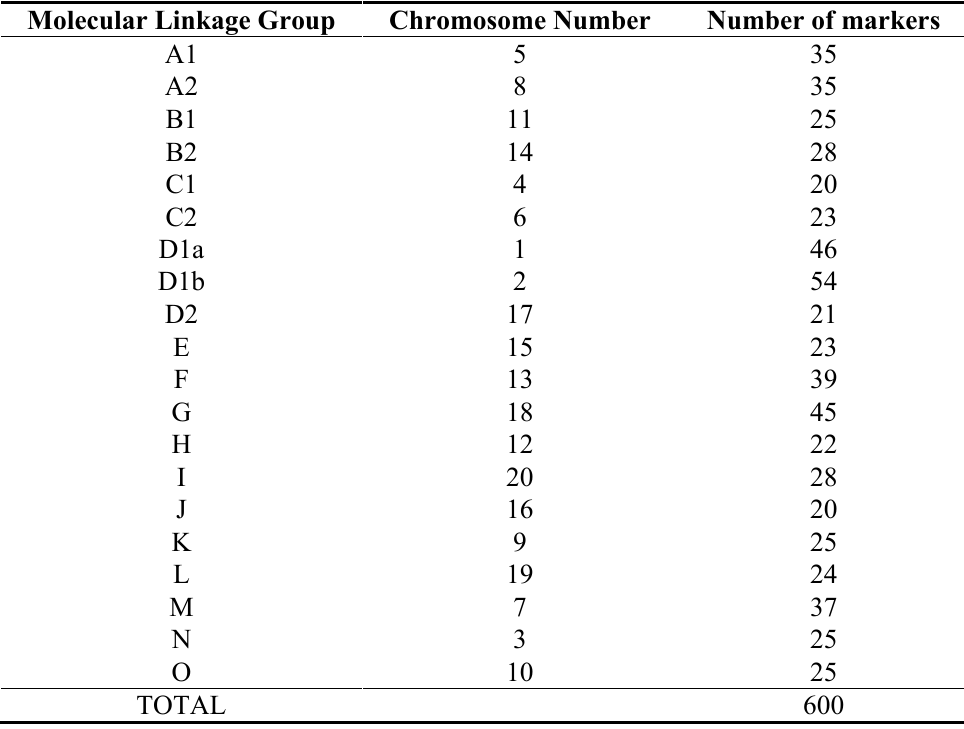
Table S1. Chromosomal distribution of microsatellite markers tested for Bulked Segregant Analysis